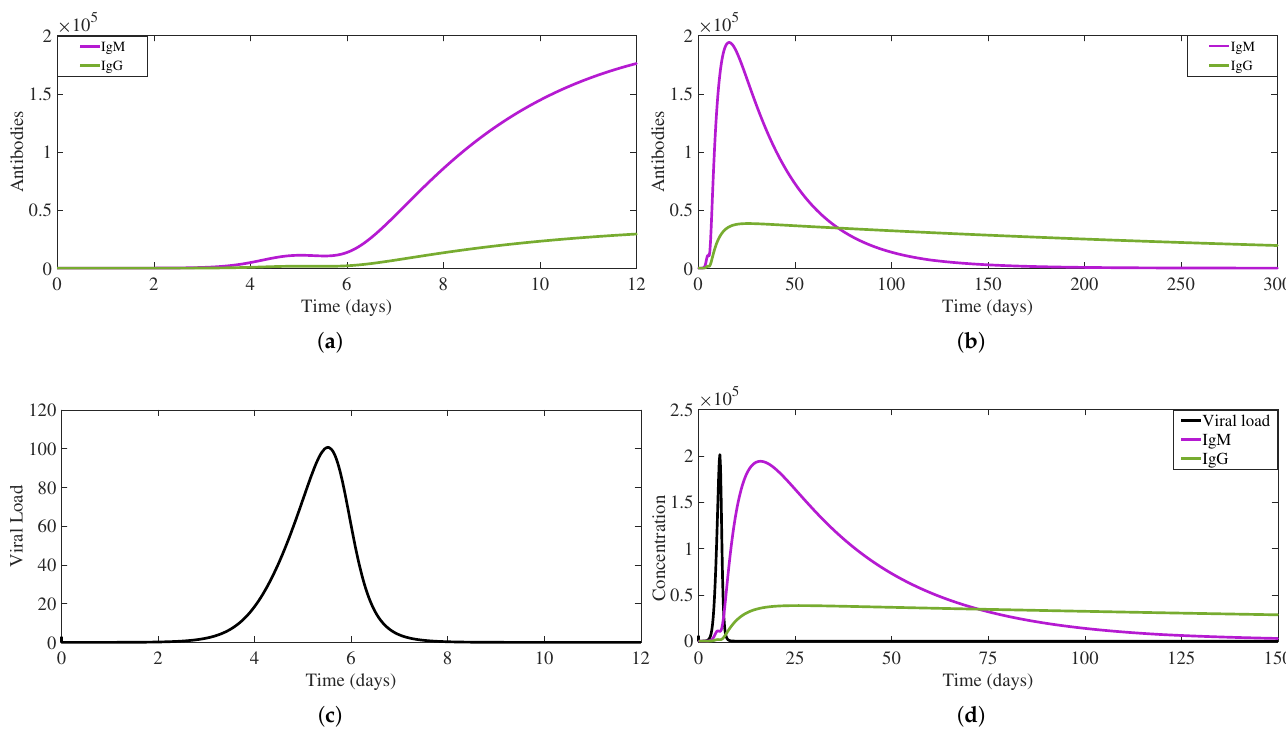
Figure 4. For a primary dengue infection, antibodies IgM (in violet) and IgG (in green) production dynamics are shown for a 10 days period ( a ) and for a 300 days period ( b ). Free virus particle dynamics for a 12 days period is shown in ( c ). The complete process of viral load in the presence of antibodies is shown in ( d ). Here, for better visualization, free viruses were scaled to 2000. The initial values used for these simulations are S ( t 0 ) = π S / µ S , I ( t 0 ) = 0, S m ( t 0 ) = π M / µ S , P ( t 0 ) = 0, M ( t 0 ) = 0, and G ( t 0 ) =